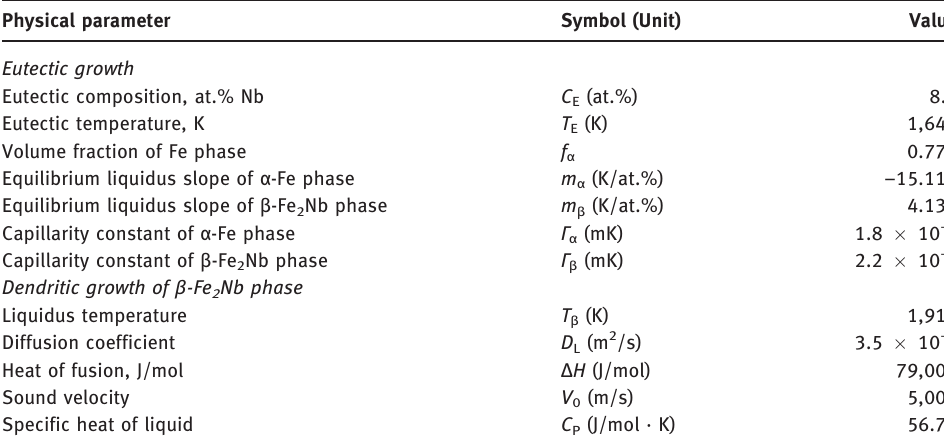
Table 1: Physical parameters used for calculations in Fe-Nb alloys [5, 17]. Physical